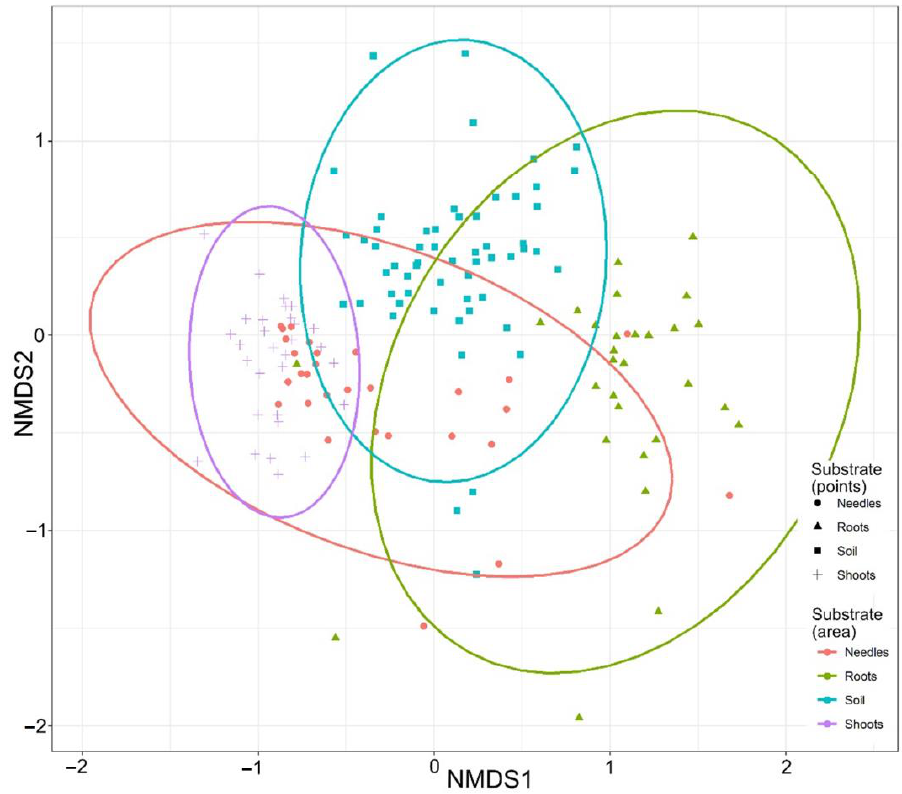
Figure 8. Nonmetric multidimensional scaling (NMDS) of fungal communities showing differences and similarities in needle, shoot, root, and the rhizosphere soil samples of Picea abies . For each substrate, each point in the diagram represents a single sampling site.